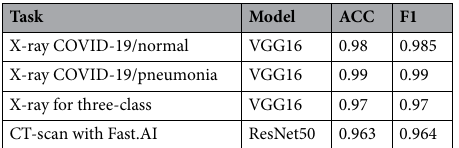
Table 7. Best result of our models for X-ray and CT scan